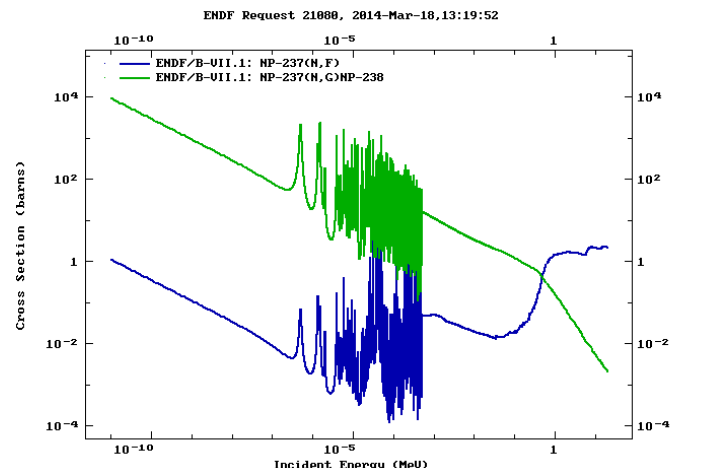
Figure 1. Np-237 neutron-caused fission (dark blue) and capture (green) cross section dependence on energy [5]